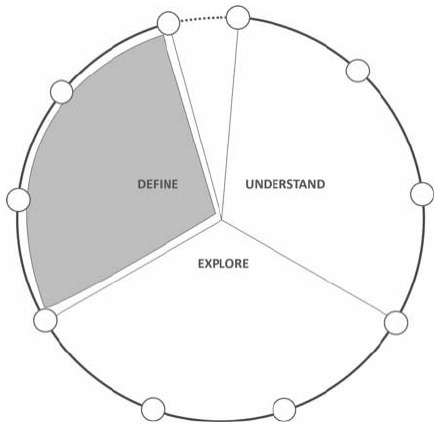
Figure 6. PSS design process phase: Define.